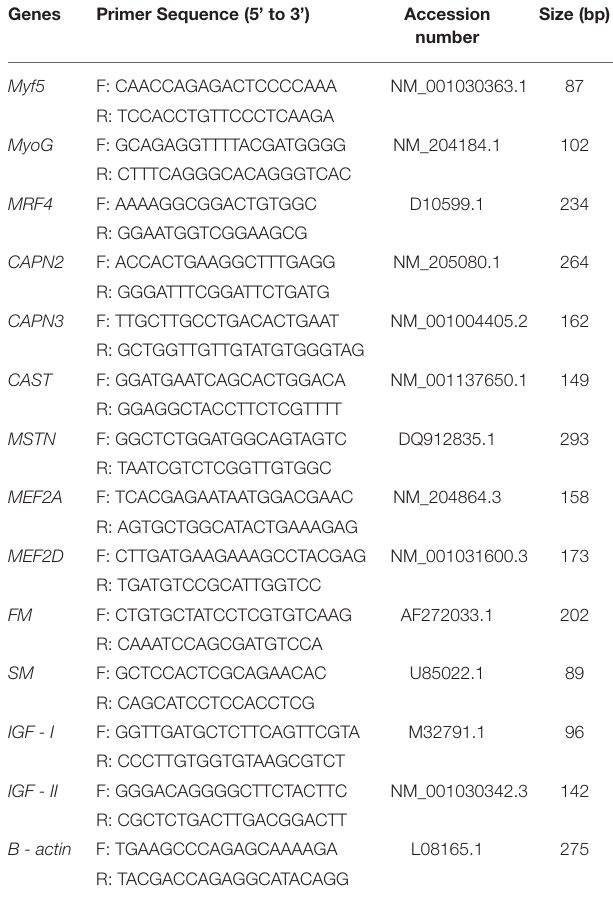
TABLE 3 | The primers for qRT-PCR.